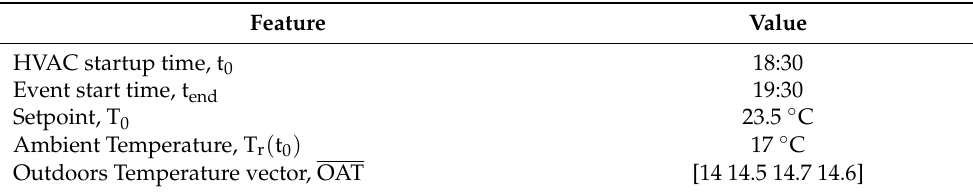
Table 2. Control request & context data.